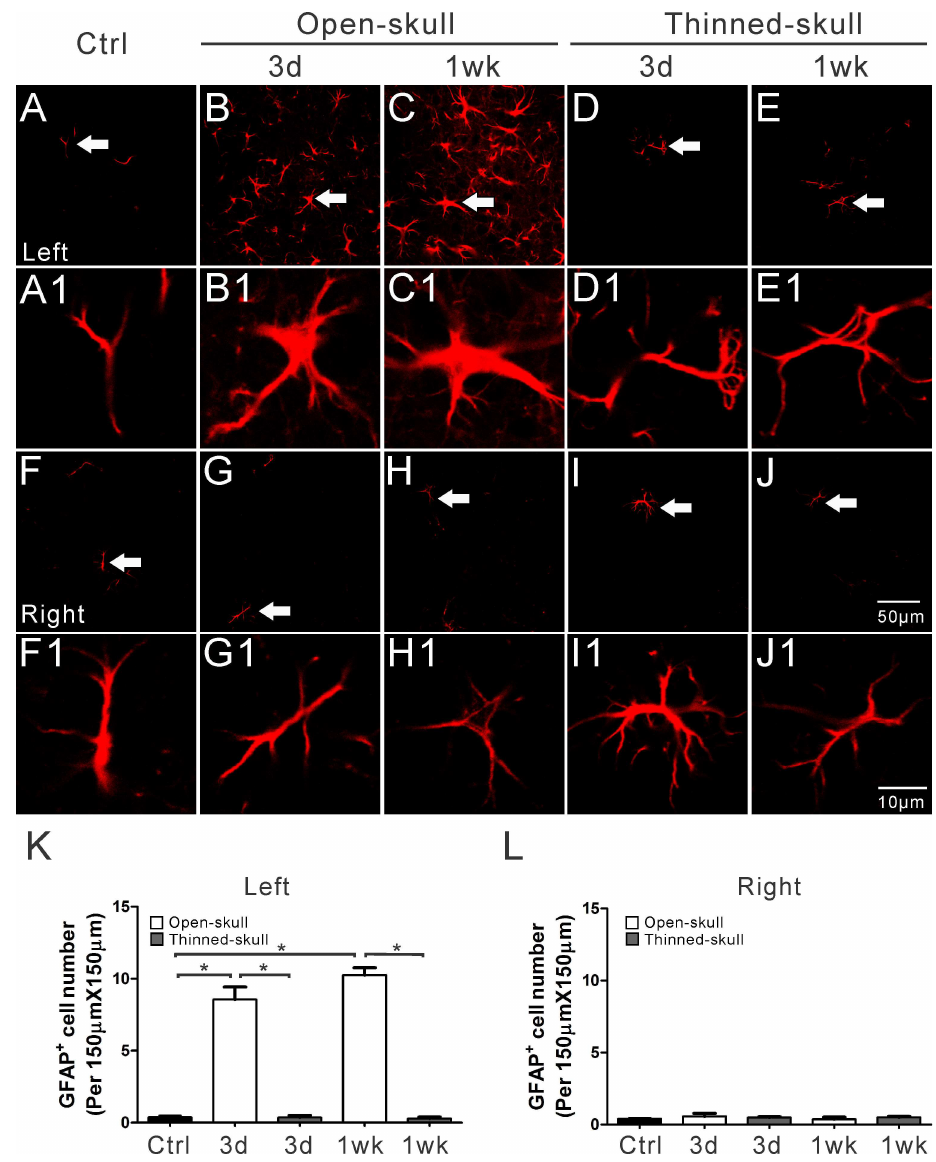
Fig 4. Immunohistochemical staining of GFAP in fixed tissue sections following open-skull and thinned-skull surgery in GFAP-GFP transgenic mice. Expression of GFAP (red) is a prototypical immunohistochemicalmarker of reactive astrocytes. GFAP positive astrocytes increasedmassively on the surgery side (left side) of the neocortexat 3 d and 1 wk after open-skullsurgery (B, C) but not after thinned- skull surgery (D, E). Minimal GFAP positive astrocytes occurred on the contralateral side (right side) (G-J) and in control mice (A, F). The arrows in figures A-J denote the astrocytes that are enlargedas in figure A1-J1, respectively. Summarized data (K, L) indicate significantly more GFAP positive astrocytes in the left neocortex at 3 d and 1 wk in open-skullmice than in thinned-skull mice or in control mice (K), with no significant difference in the right neocortex(L). * p < 0.05, by one way ANOVA with Tukey’s post-test (n = 6 per